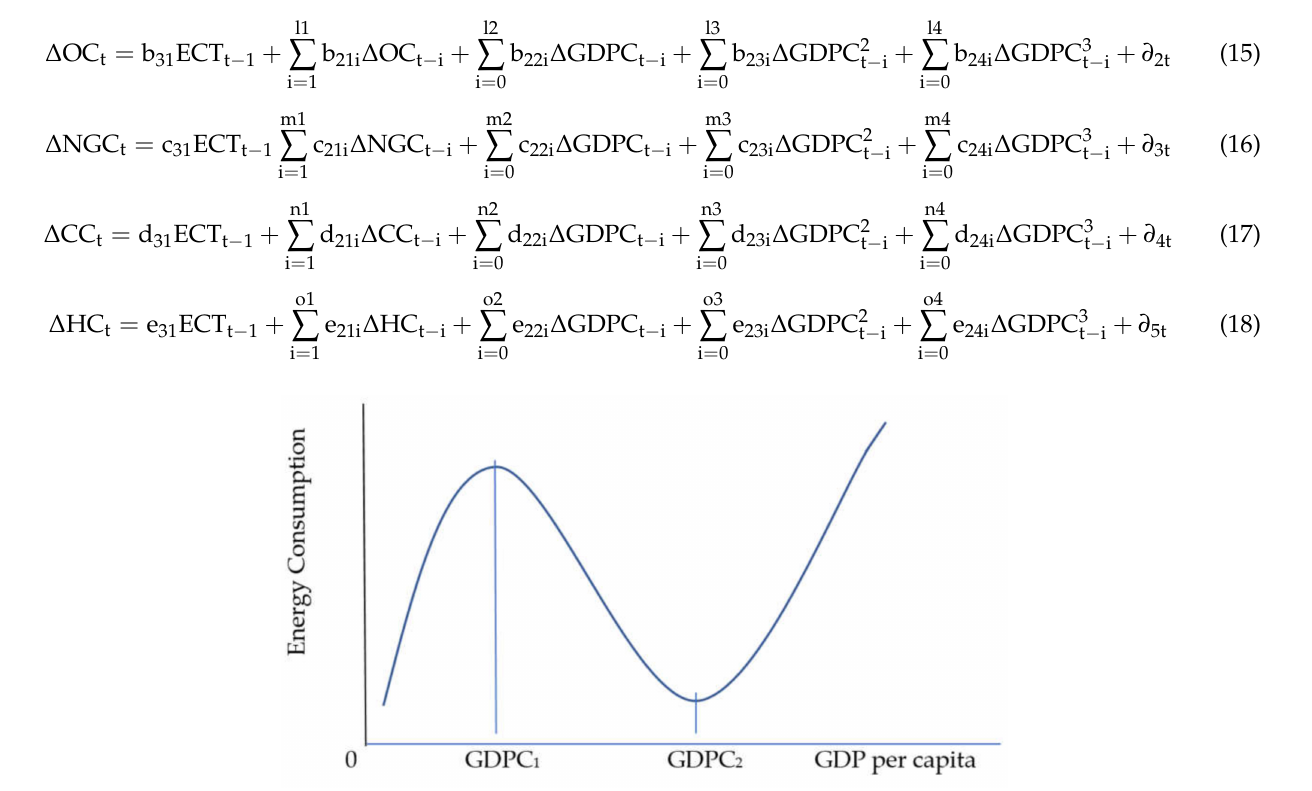
Figure 3. The N-shaped